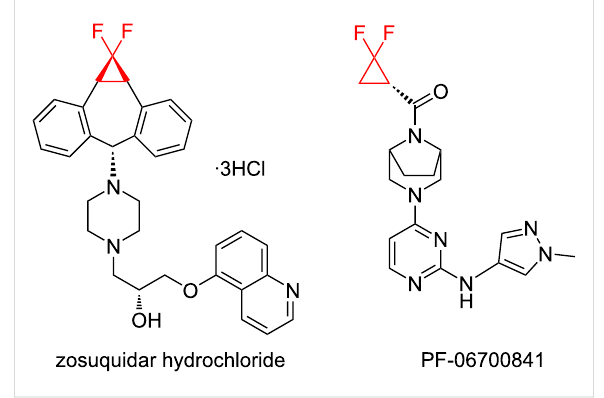
Figure 1: Structures of zosuquidar hydrochloride and PF-06700841.